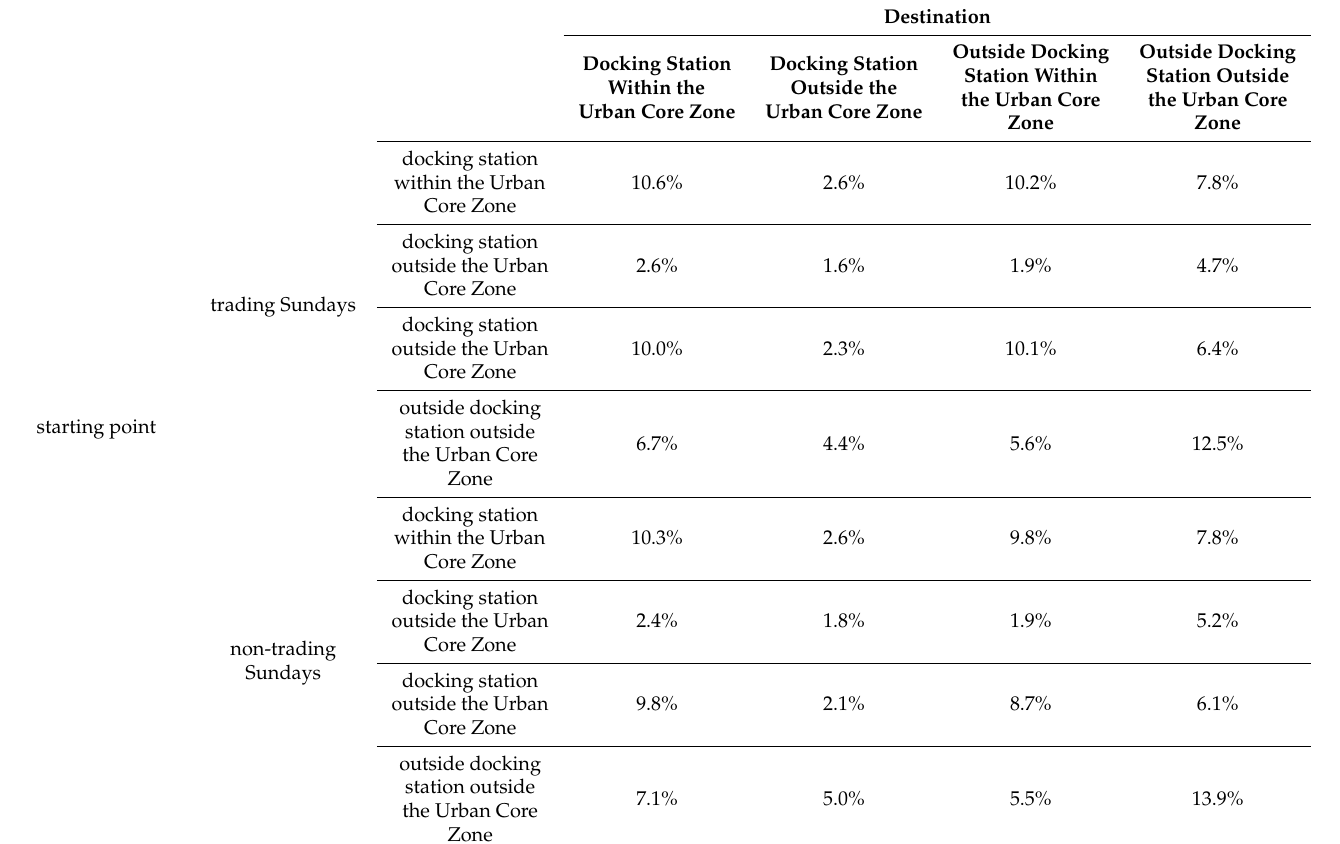
Table 6. The structure of the percentage of ŁPB trips on trading and non-trading Sundays by starting point and destination with regard to the distribution of docking stations in Ł ó d´z in